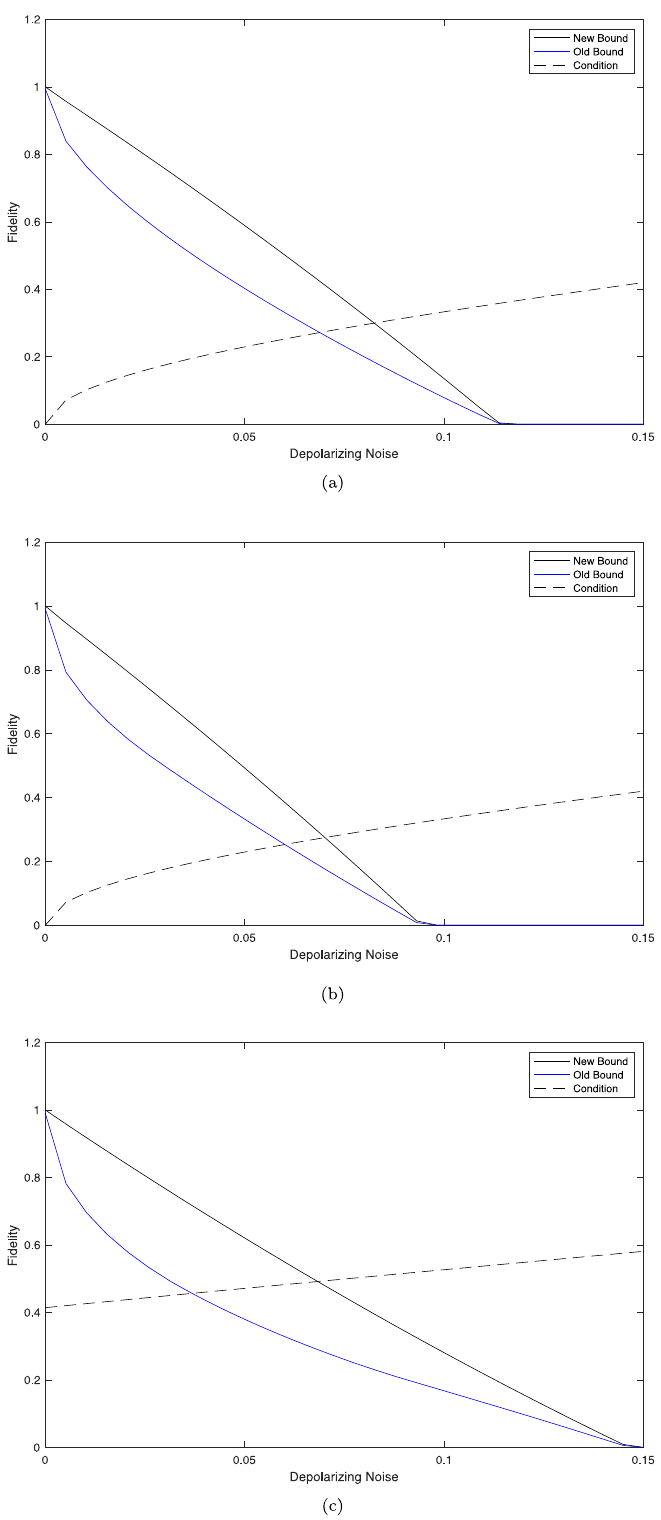
Fig. 1 Fidelity Bounds for depolarizing noise. Fidelity bounds as a function of depolarizing noise in several scenarios (described in main text), regarding the repetition-code protocol de fi ned in our Introduction. The blue and black solid lines respectively represent the fi delity bounds derived via the previous approach (based on the Fuchs – van de Graaf inequality) and our new algorithm. It can be seen that the latter yields substantially better bounds. The dashed lines show the value of threshold values for which advantage distillation is possible according to the condition F ð ρ E thresholds are q (cid:5) 8 : 3 % ; q (cid:5) 7 : 0 % , and q (cid:5) 6 : 7 % (from top to bottom in the scenarios shown